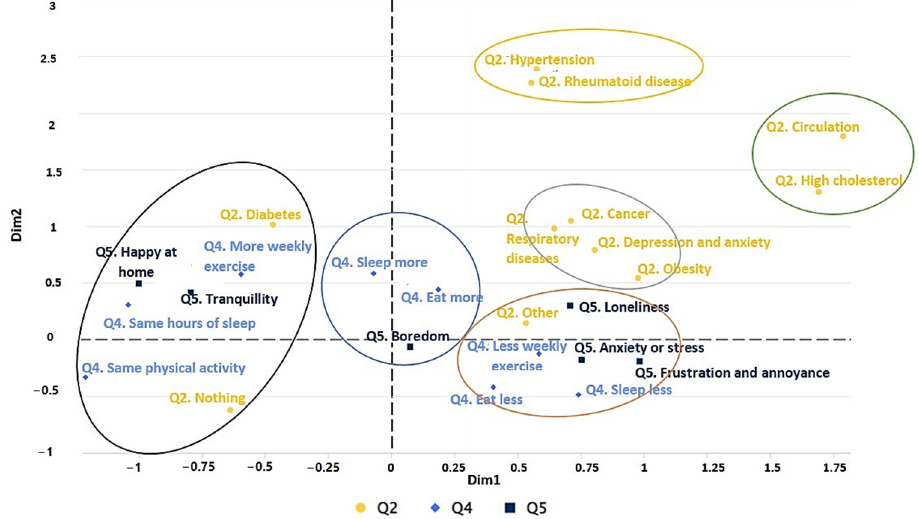
Figure 8. Multiple factor analysis (MFA) of the variables Q2, Q4, and Q5.